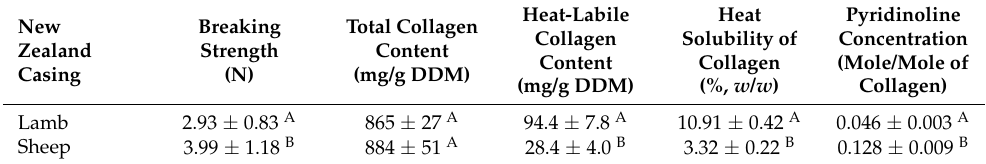
Table 3. Toughness property and collagen characteristics of natural lamb and sheep